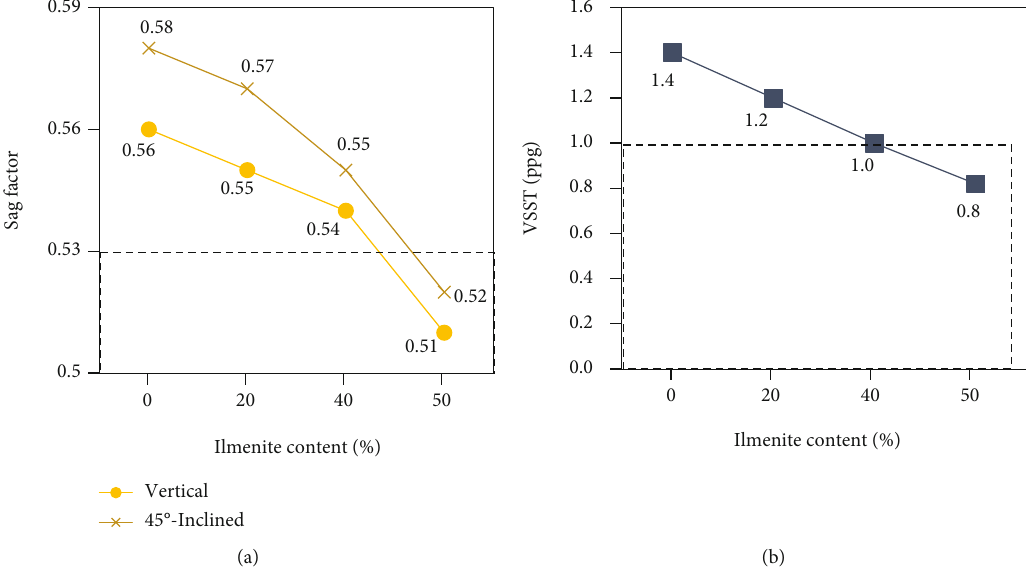
Figure 5: Results of sag tests under (a) static conditions at 350 ° F and (b) dynamic conditions at 150 ° F.